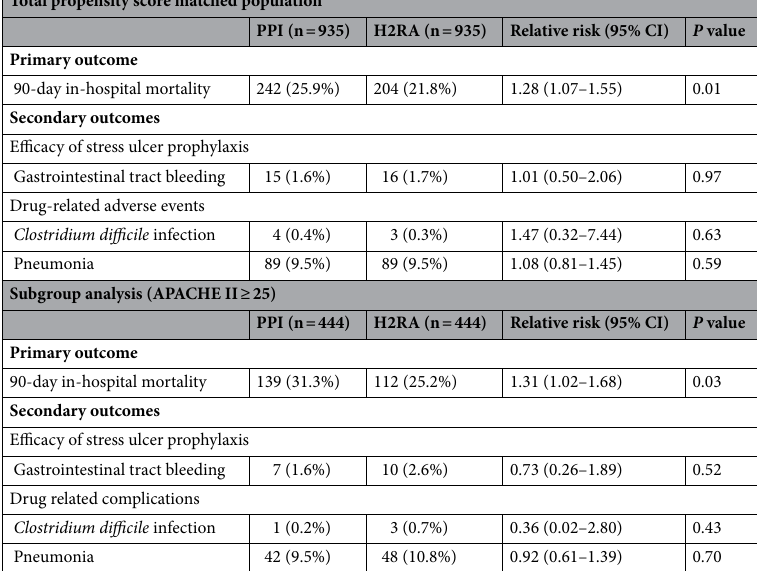
Total propensity score matched